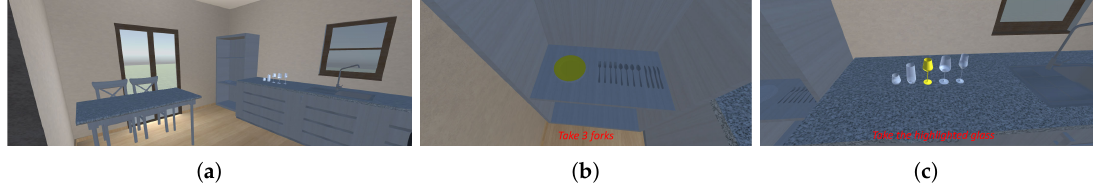
Figure 6. Example of steps to be performed for the second exercise. The patient enters the exercise room ( a ), then it takes the required number of silverware ( b ) and the required glass ( c ).